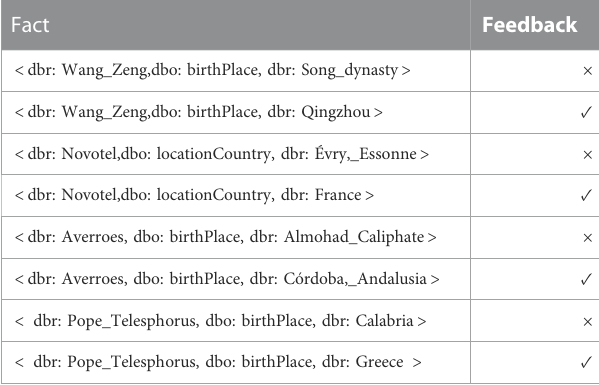
TABLE 1 Some examples of con fl ict feedbacks. Fact